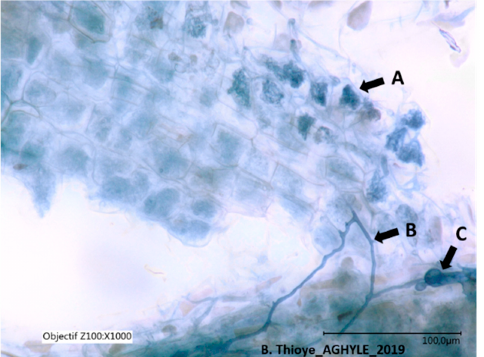
Figure 2. Walnut tree root ( Juglans regia L.) colonized by arbuscular mycorrhizal fungi: ( A ) Arbuscules for nutrient exchange; ( B ) Hyphae colonizing the roots; ( C ) Vesicles for nutrient storage. Roots were stained with blue ink.